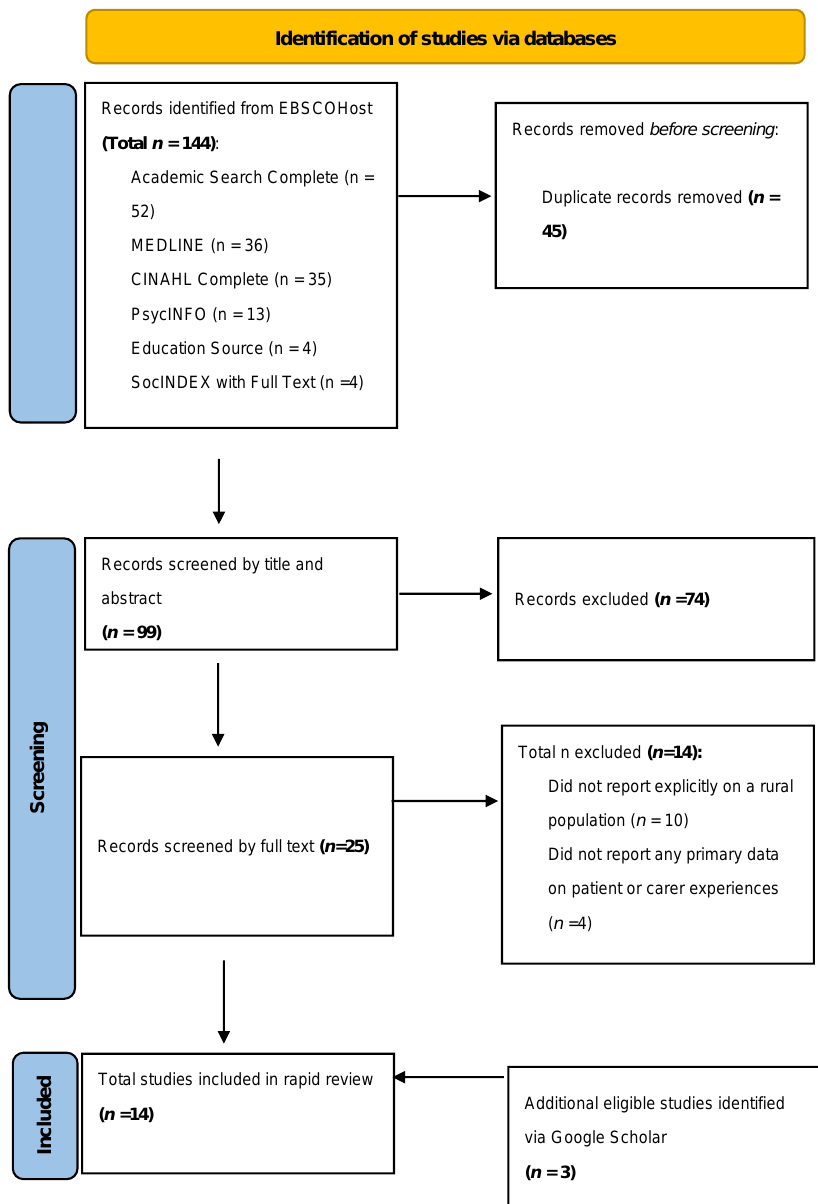
Figure 1. PRISMA Flow Diagram.